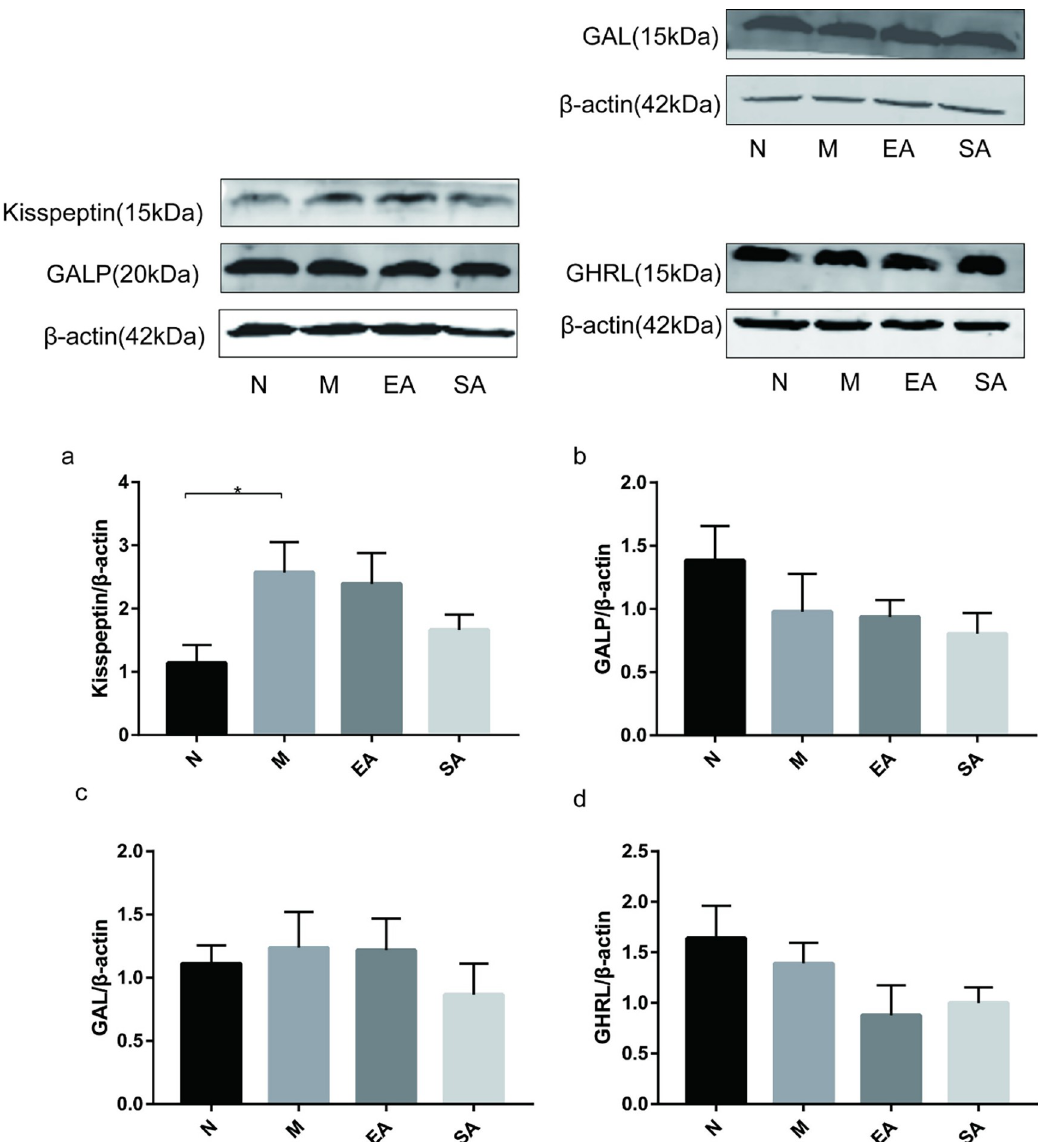
Fig 7. Protein expression of kisspeptin, GALP, GAL and GHRL in the pancreas (a-d). N, normal group; M, model group; EA, electroacupuncture group; SA, sham acupuncture group; GAL, galanin; GALP, galanin-like peptide; GHRL, ghrelin; The values are shown as mean ± SEM. N vs M, � P <